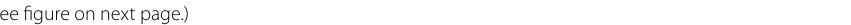
figure on next Fig. 2 SOX2OT overexpression promoted autophagy and relieved DN-induced renal injury in vivo. DN mice were injected with lentivirus carrying pcDNA-SOX2OT or pcDNA-vector. a Blood glucose, 24 h proteinuria, serum creatinine, blood urea nitrogen levels in DN mice after SOX2OT overexpression. b Relative kidney weight in DN mice in response to SOX2OT overexpression. c HE, Masson and LC3 staining of renal sections in DN mice with SOX2OT overexpression. IHC staining detected fibronectin and collagen IV levels. Scale bar: 50 μm. d SOX2OT mRNA expression was determined by RT-qPCR in the kidney of DN mice with SOX2OT overexpression. e Western blot analysis of LC3II/LC3I, Beclin1 and p62 in the kidney of DN mice after SOX2OT overexpression. GAPDH was used as a loading control in western blot analysis. Error bars represent the mean three independent experiments. *p < 0.05, **p < 0.01, ***p < 0.001, One-way-ANOVA followed by Newman-Keuls post hoc